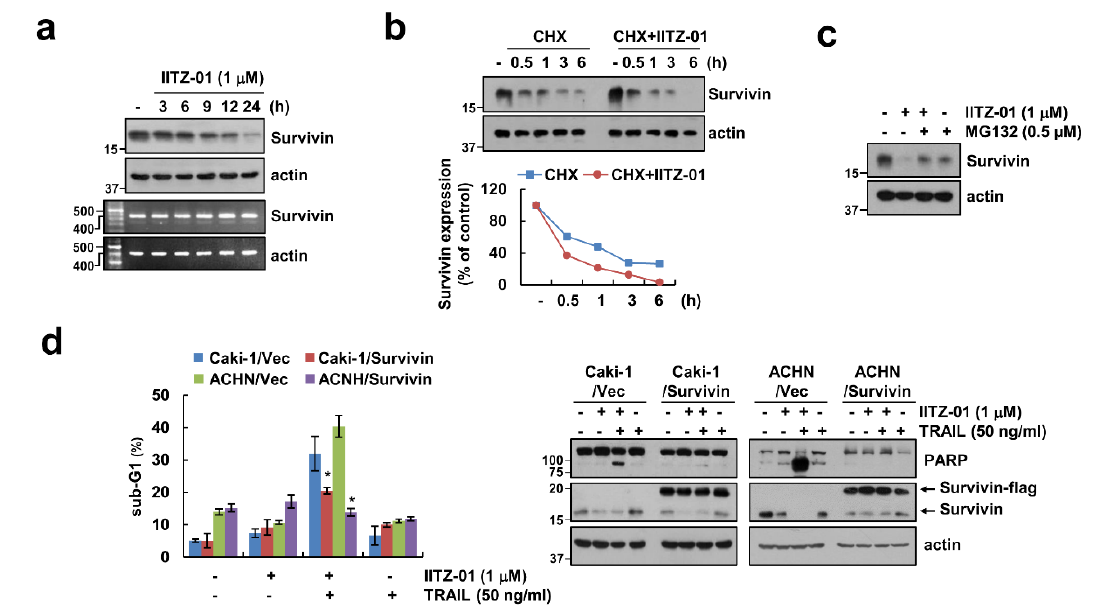
Figure 5. Survivin downregulation contributes to the sensitization effect of IITZ-01 on TRAIL-induced apoptosis in Caki-1 cells. ( a ) Caki-1 cells were incubated with 1 μM IITZ-01 for indicated time periods. The protein and mRNA levels were determined by Western blotting or RT-PCR, respectively; ( b ) Caki-1 cells were incubated with 20 μg/mL CHX and/or 1 μM IITZ-01 for the indicated time periods. The band intensity of the survivin protein was measured using Image J; ( c ) Caki-1 cells were pretreated with 0.5 μM MG132, and then incubated with 1 μM IITZ-01 for 18 h; ( d ) Vector-transfected cells (Caki-1/Vec and ACHN/Vec) and survivin-overexpressing cells (Caki-1/Survivin and ACHN/Survivin) were incubated with 1 μM IITZ-01 and/or 50 ng/mL TRAIL for 18 h. The values in graph ( b , d ) represent the mean ± SD of three independent experiments. * p < 0.05 compared to the IITZ-01 plus TRAIL in Vector cells.